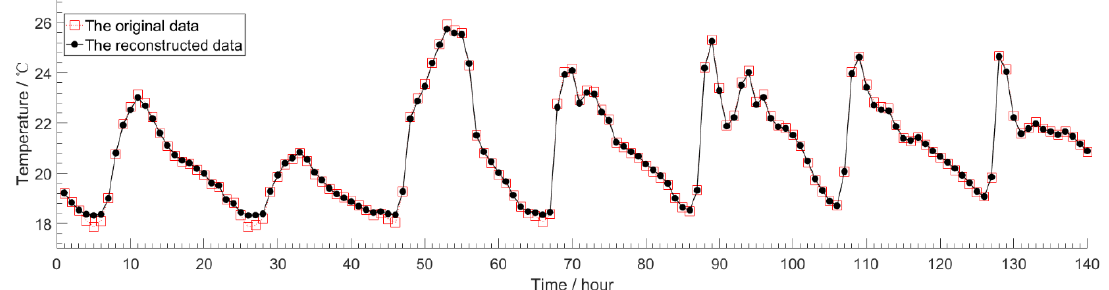
Figure 8. The reconstructed data and the original data of node 7 under CR is 10.